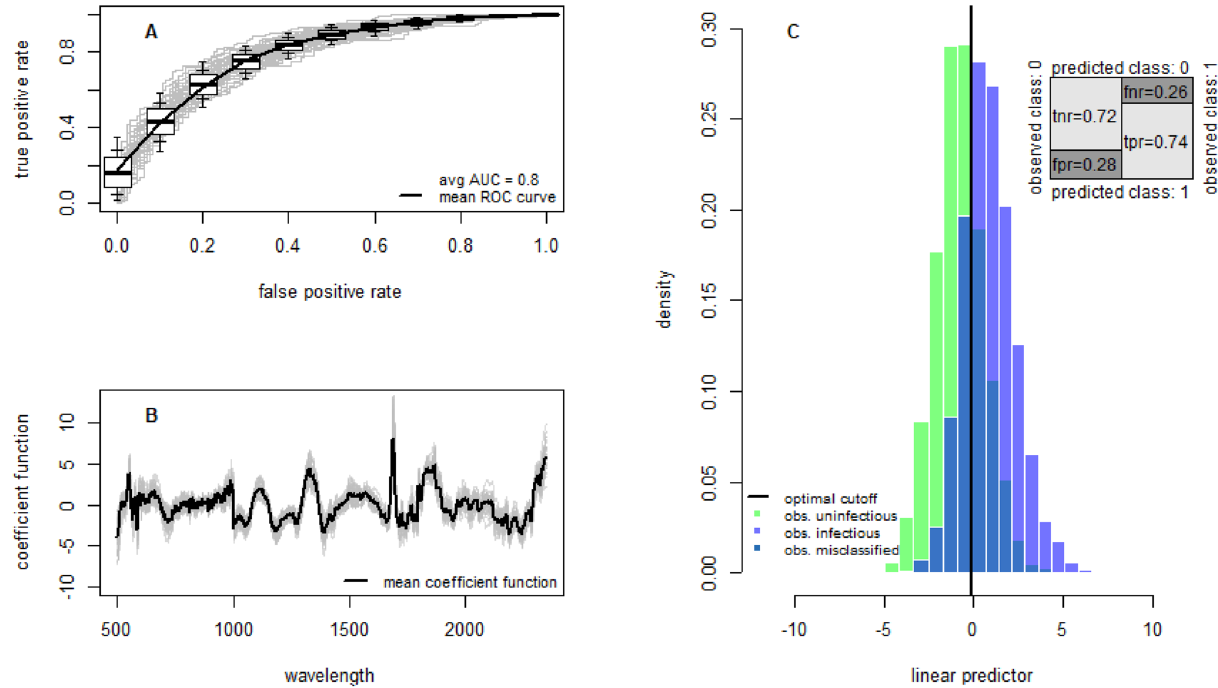
Figure 1. The ability of NIRS to predict laboratory-reared mosquitoes infectious with wild parasites. All models were trained on sporozoite positive and sporozoite negative laboratory reared mosquitoes using all the data presented in Table 1. ( A ) Receiver operating characteristic (ROC) curve illustrating the diagnostic ability of the best-fit model. Overall performance is given by the average area under the ROC curve (AUC). Figure illustrates the false positive and true positive rates achievable for different classification probability thresholds. A theoretical perfect diagnostic would be in the top left corner. Average ROC curve shown by the solid line with boxplots showing the variability for 50 randomizations of the training, validation and testing datasets (horizontal black line shows the median whilst the 25th/75th, 15th/85th and 5th/95th percentiles are shown by box edges, inner and outer whiskers, respectively). ( B ) Coefficient functions for the best fit model for each of the 50 dataset randomizations (grey lines) and the overall average (black line). ( C ) Histogram showing the predicted status of tested mosquitoes that were infectious (light blue colored bars) or uninfectious (green bars).Vertical solid black line indicates the best threshold for differentiating between infectious or uninfectious mosquitoes. Darker blue bars indicates where the two distributions overlap and show those mosquitoes misclassified—false negatives are shown to the left of the optimal classification threshold line and false positives to the right. Inset shows the confusion matrix illustrating the different error rates: true negative rate (tnr, specificity); false negative rate (fnr); false positive rate (fpr); and true positive rate (tpr,